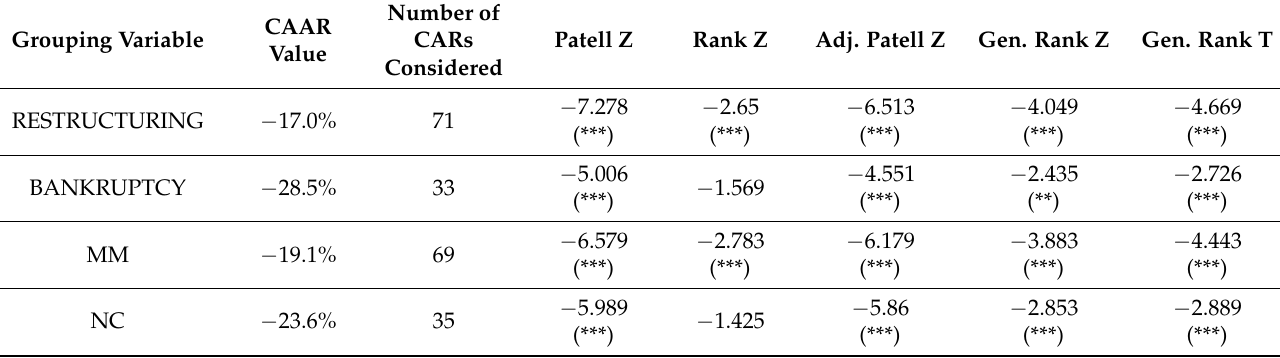
Table 8. The values of test statistics for the performed test (Option 2 &